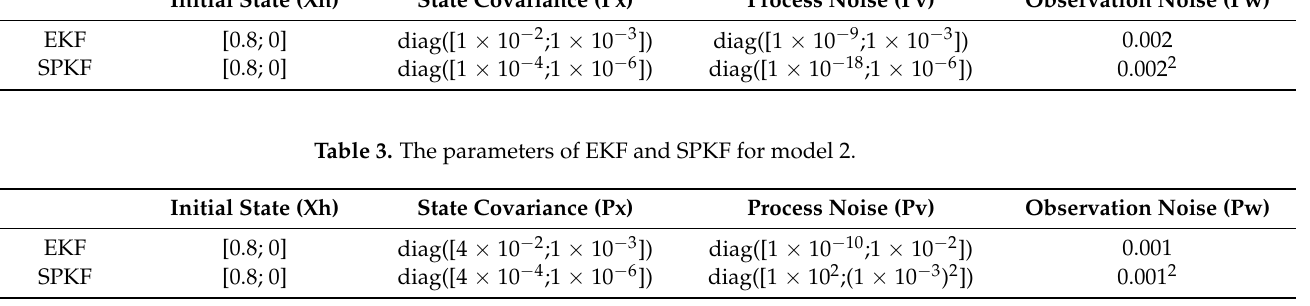
Table 2. The parameters of EKF and SPKF for model 1.